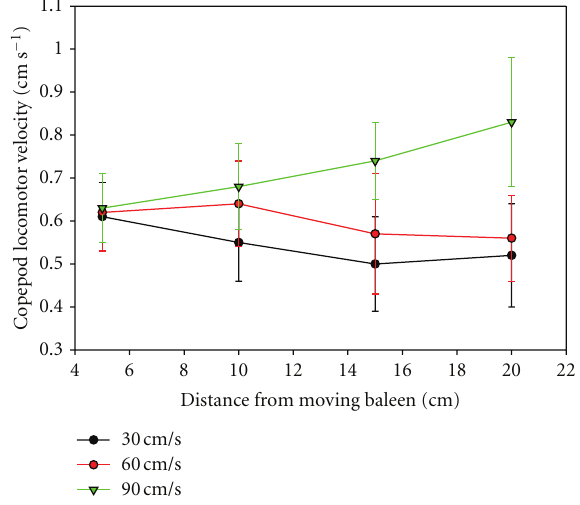
Figure 7: Copepod ( Calanus ) locomotor velocity (mean, N = 30; error bars = 1SD) in “still” tank, measured at varying distance from closest point of baleen moving at 30–90 cm s − 1 , in dark using PIV (at 22 degrees C).